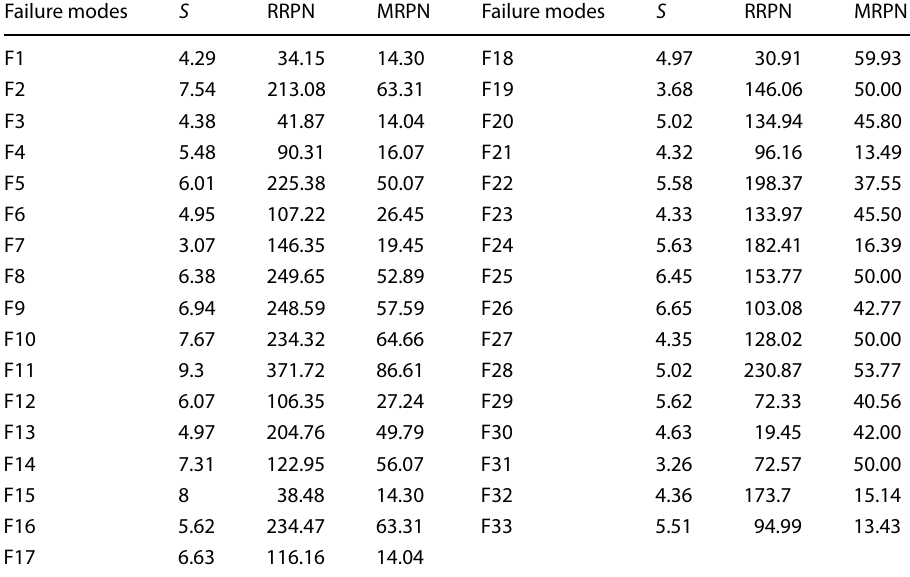
Table 9 Values of modified risk priority number (MRPN) for failure